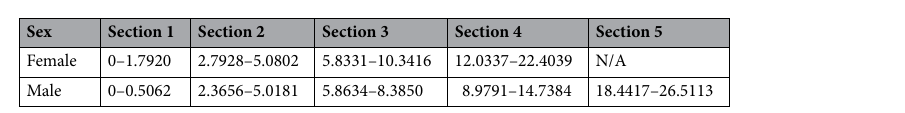
Table 5. Sections of the ranked ALS incidence rates in Ohio defined by Jenk’s natural breaks. For females, the specified number of sections = 4, and for males, the number = 5. N/A = not applicable.